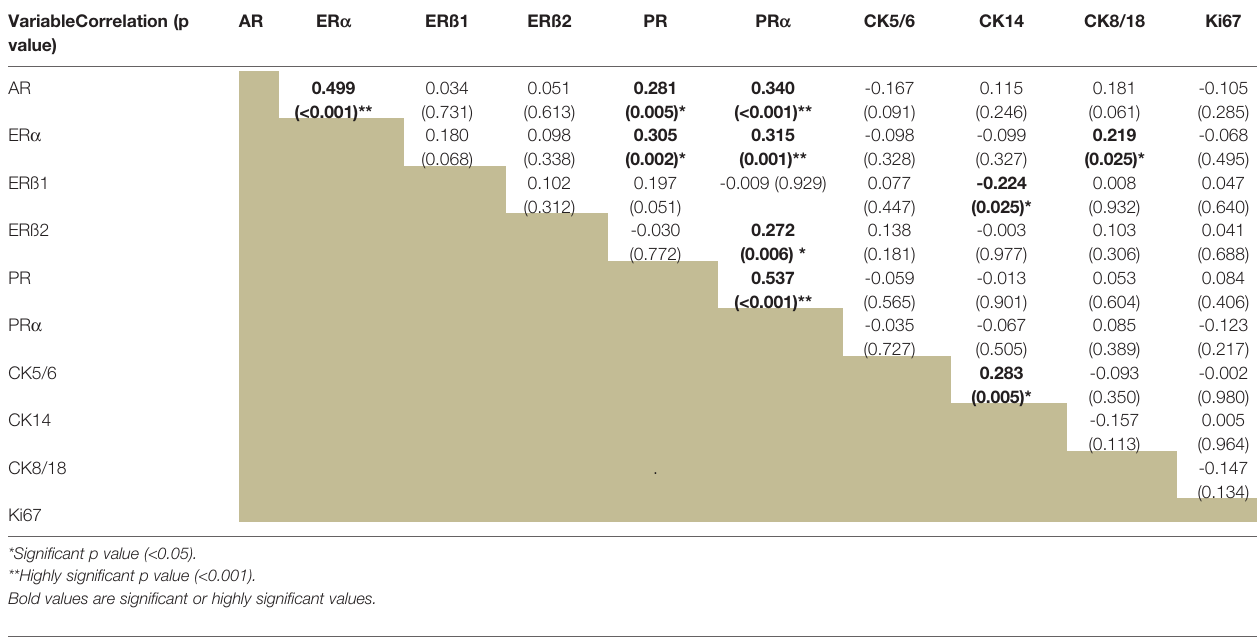
TABLE 6 | Comparative expression of hormone receptors in gynecomastia and male and female breast cancer. Condition % expression of hormone receptor